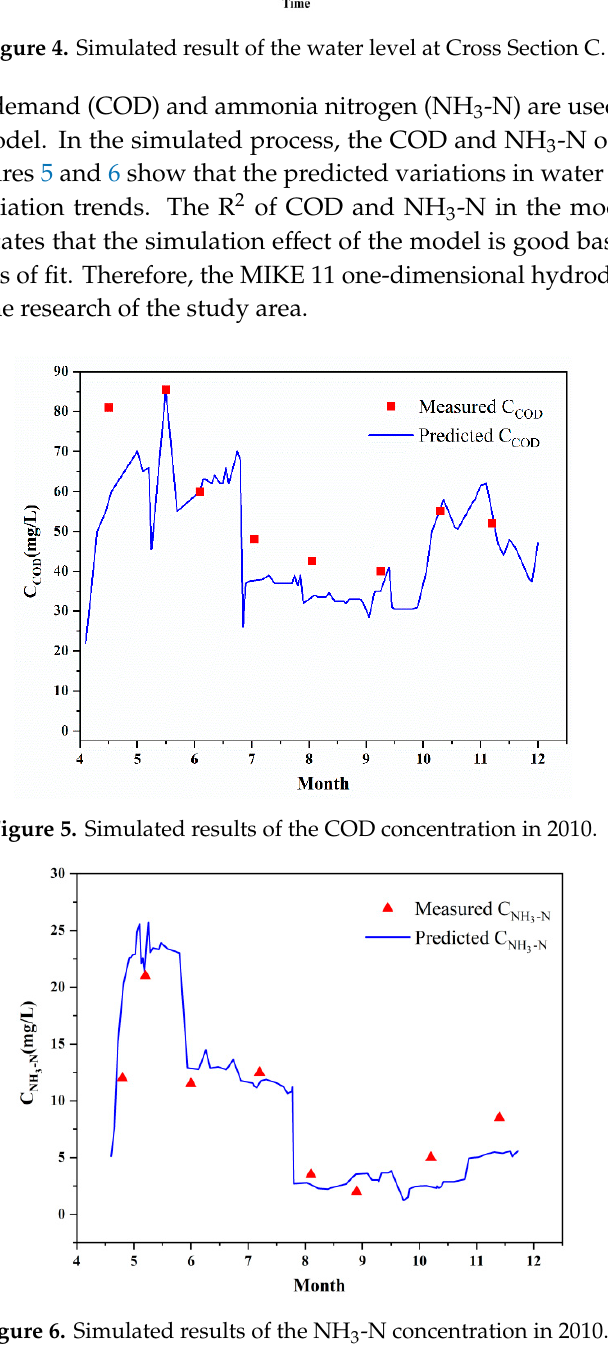
Figure 6. Simulated results of the NH 3 -N concentration in 2010.